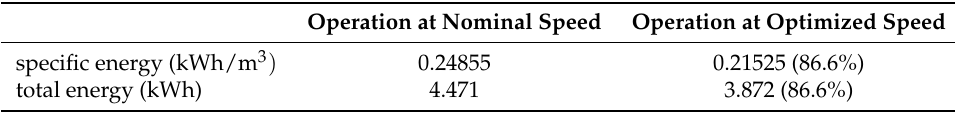
Table 1. Energy savings when operating speed optimized pumps.